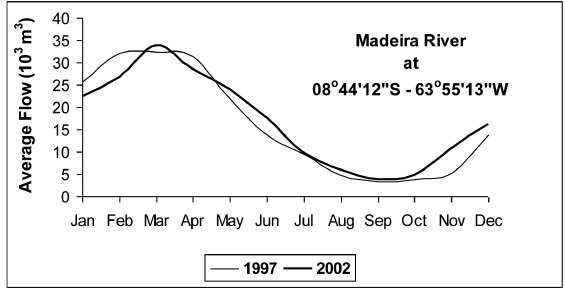
Figure 4. Monthly instantaneous fluxes of water (103m3), estimated for the Madeira River in 1997 and